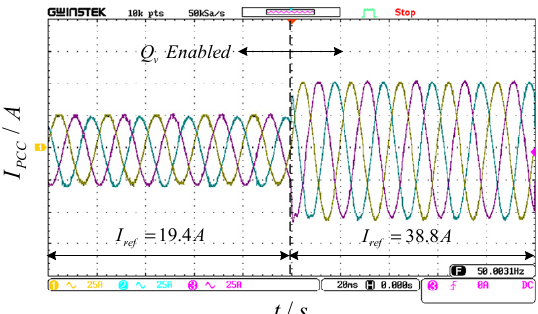
rent of TFSCI changes. Figure 27. Experimental result of current waveform at PCC after reshaping when the reference